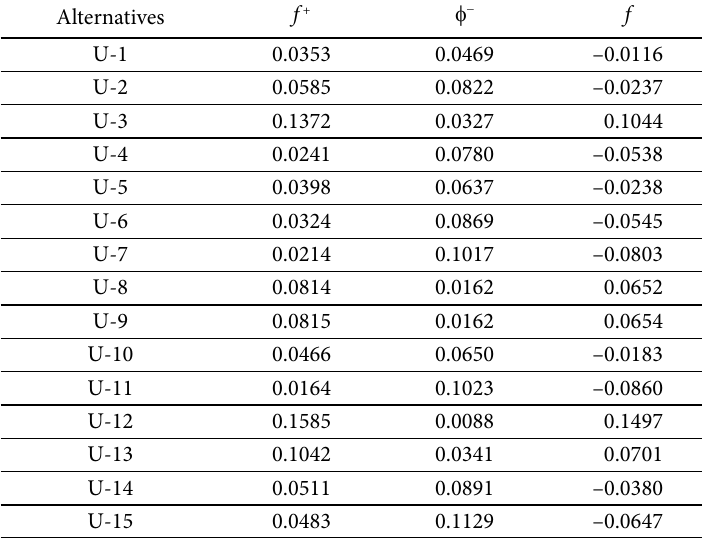
Table 13. PROMETHEE results